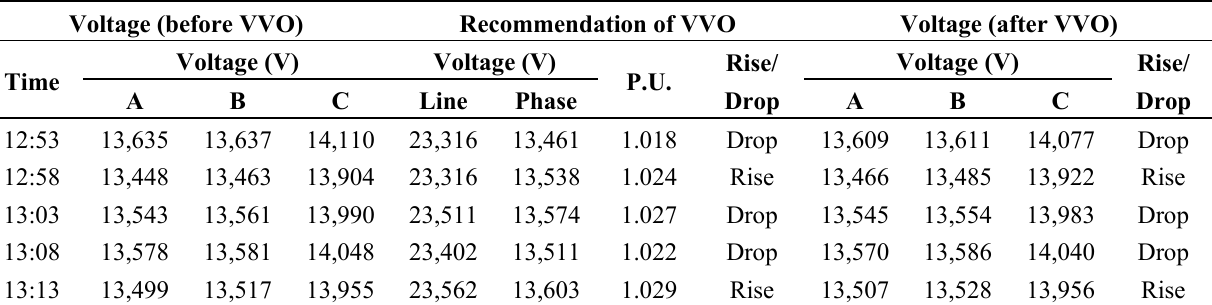
Table 12. VVO test results of periodic voltage control.